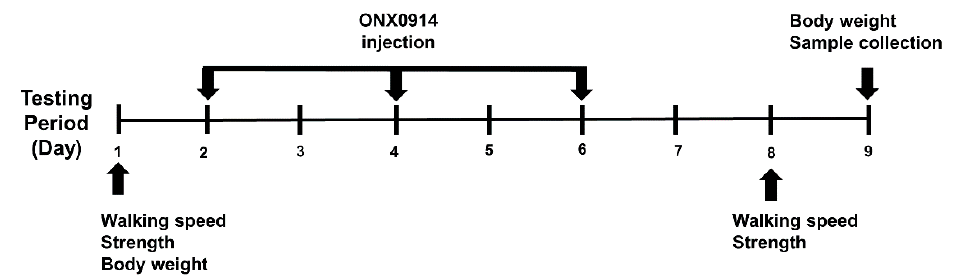
Figure 1. Experiment timeline. The duration of the testing period was nine days. The mice were evaluated for physical performance (walking speed, strength) on Day 1 and 8. Body weight was measured on Day 1 and 9. ONX-0914 (10 mg/kg) was injected subcutaneously on Day 2, 4 and 6. Muscle tissue was collected on Day 9.